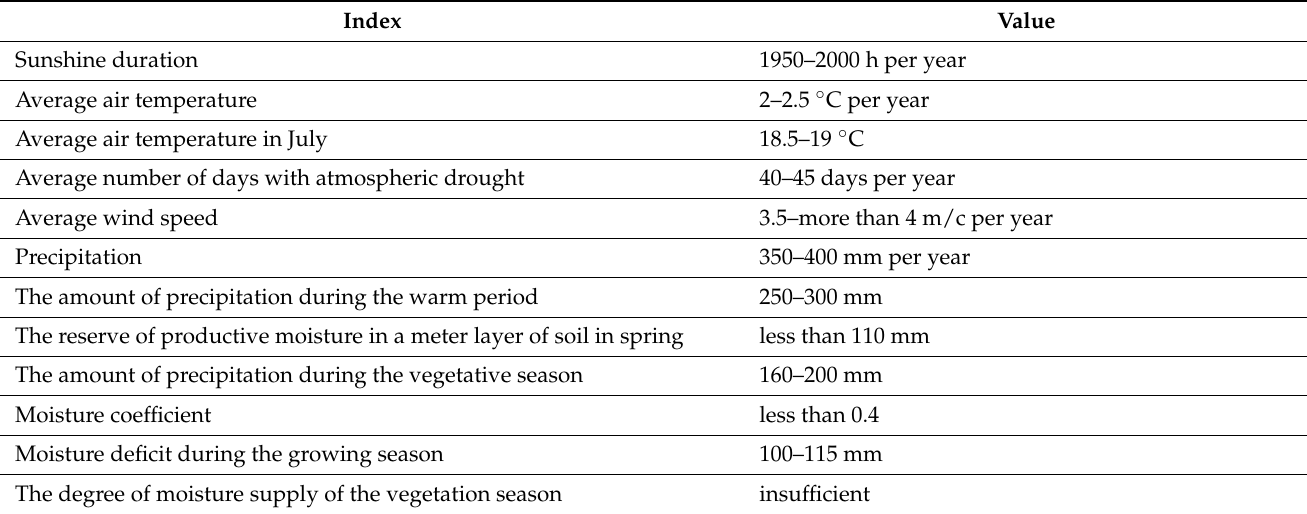
Table 1. Climatic characteristics of the studied area